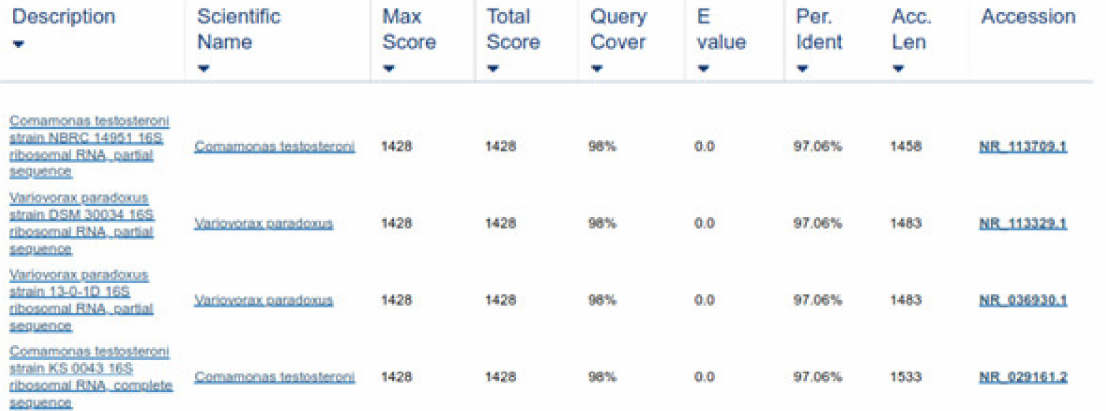
Figure 10. Sequence similarity less than 96% of ABCW, and hence, excluded.